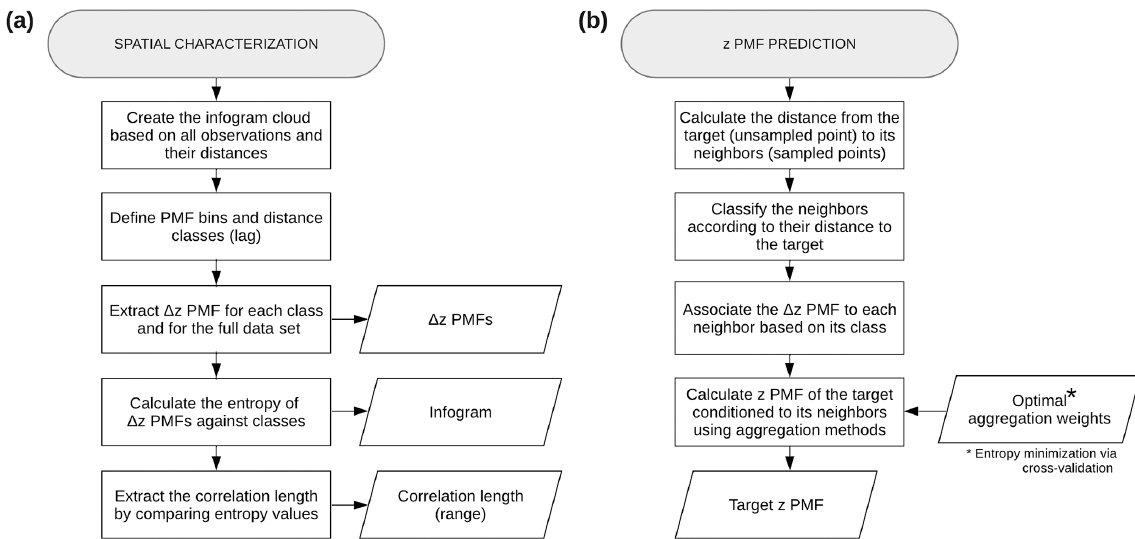
Figure 1. HER method. Flowcharts illustrating (a) spatial characterization and (b) z probability mass function (PMF)